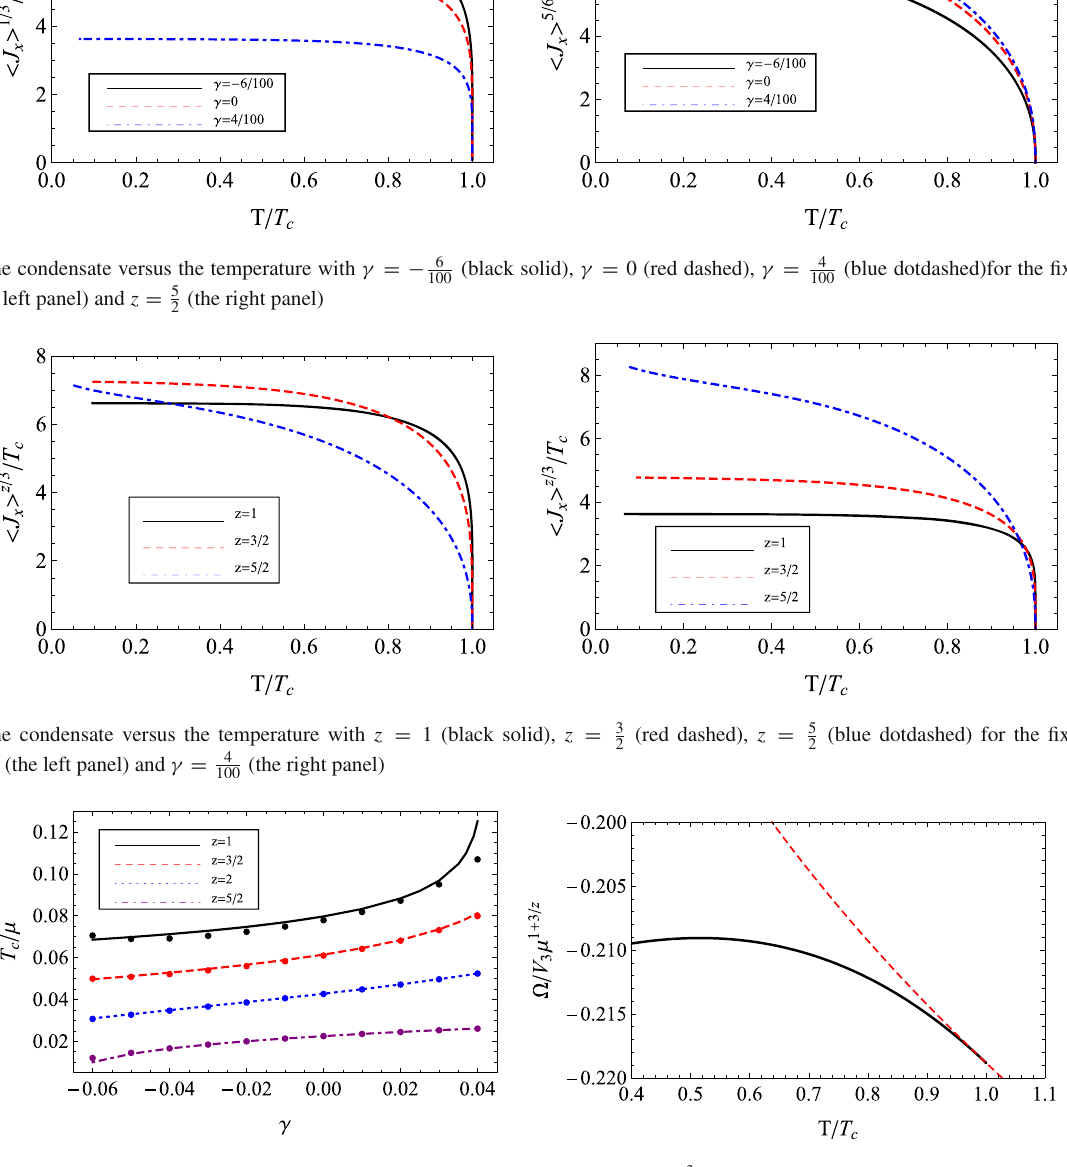
Fig. 3 The critical temperature versus the Weyl parameter γ for z = 1 (black solid), z = 3 dotted) (left) and the grand potential about the normal state(red dashed) and the superconducting state (black solid) in the case of z = 6 γ = − 1 20